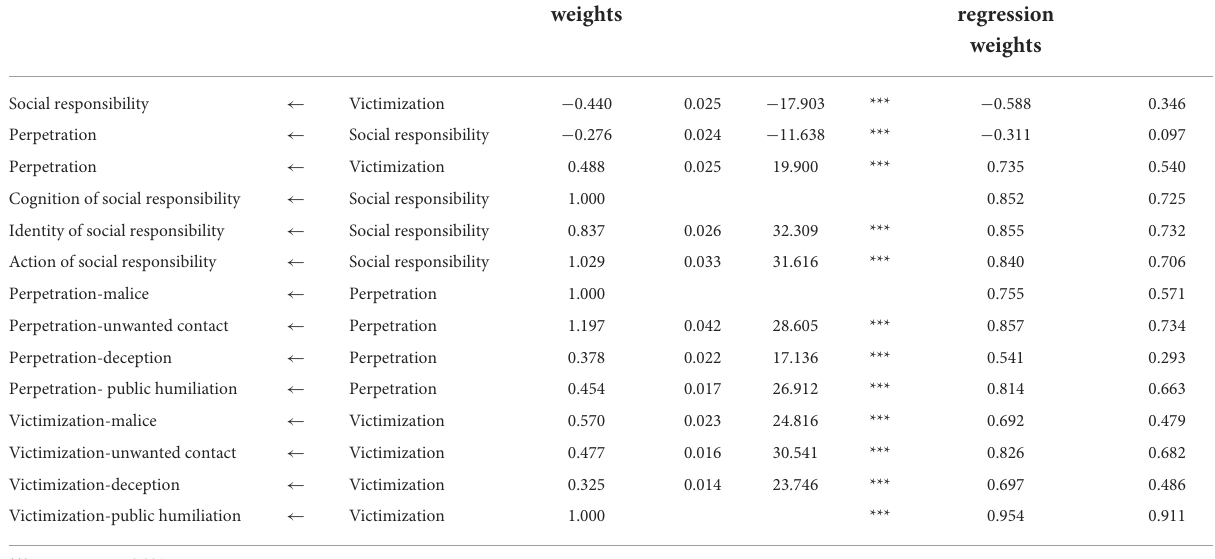
TABLE 3 Parameter estimation results of structural equation